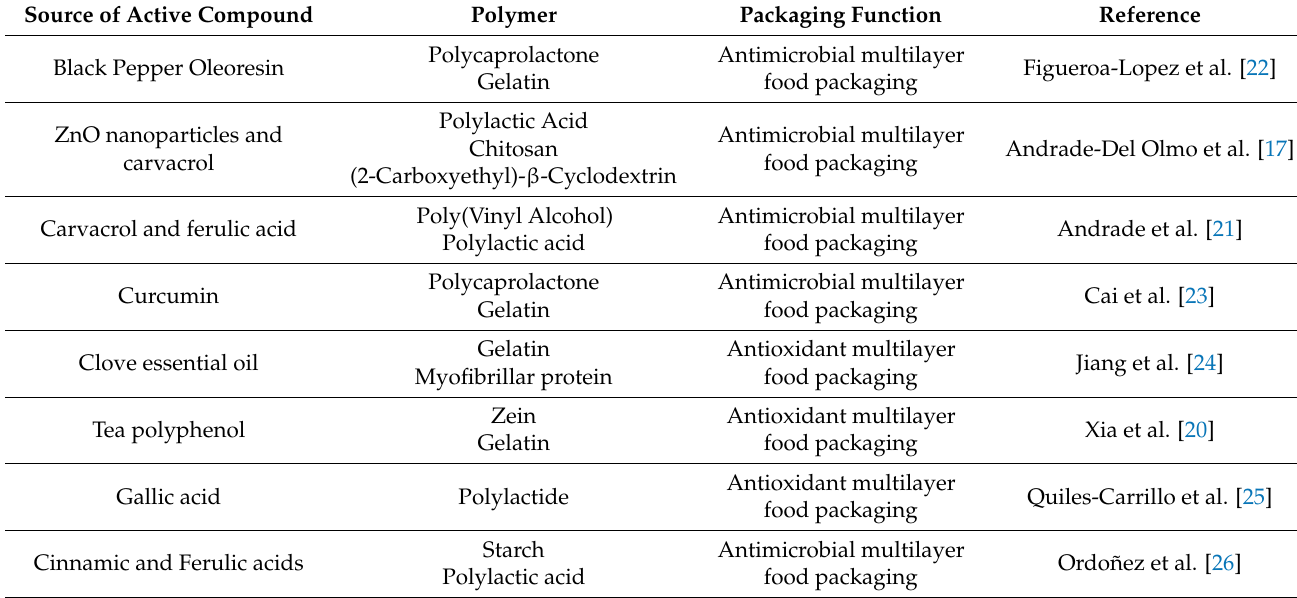
Table 1. Functionalities of multilayer food